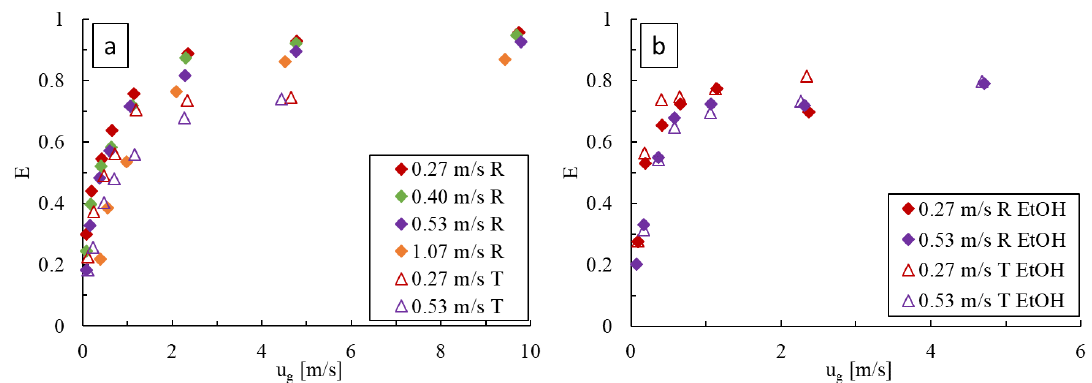
Figure 11. Comparison of the extraction efficiency, 𝐸 , at varying gas and liquid flow rates in the LL-Rhombus (R) and LL-Triangle (T) with ( a ) water and ( b ) 0.5 wt% aqueous ethanol as the liquid phase.